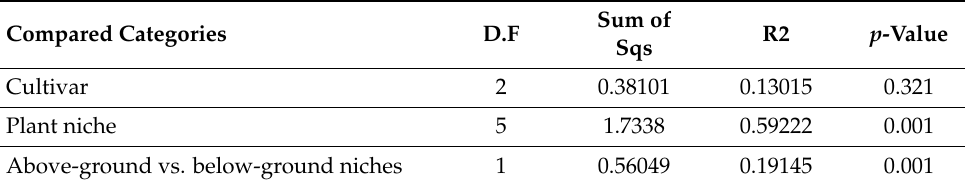
Figure 4. Principal coordinate analysis of fungal communities of the different sorghum cultivars and niches. Table 5. Comparison between cultivars, plant niche, and above- vs. below-ground niches according to the Adonis permutation